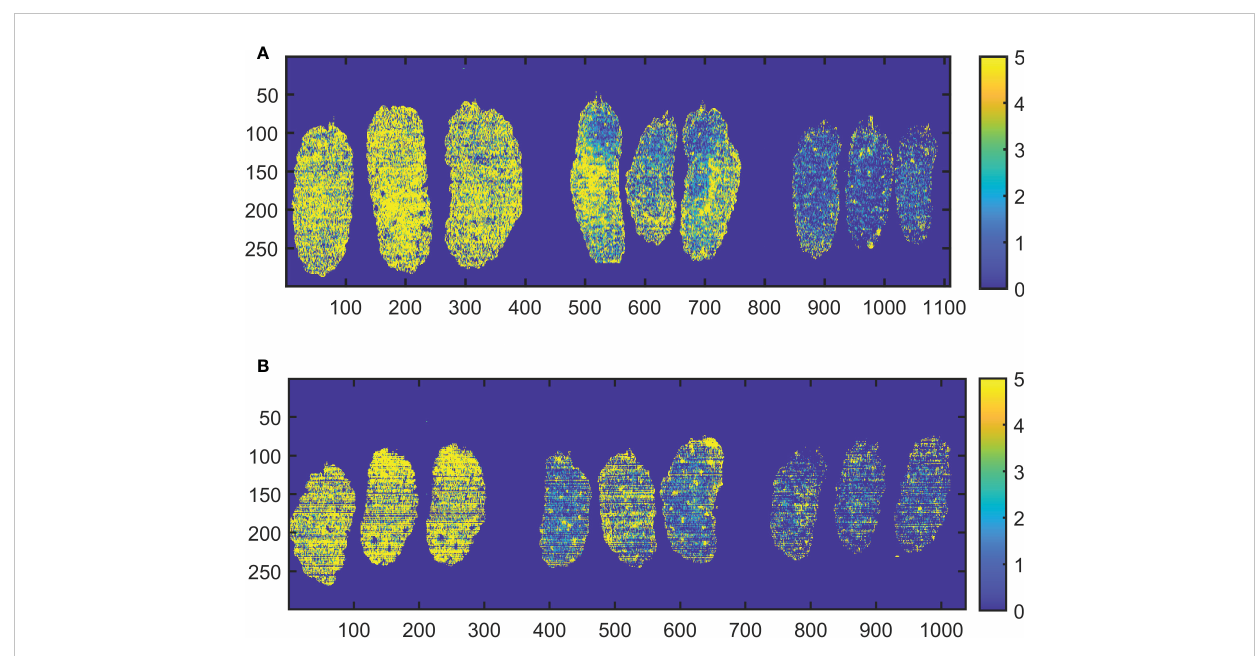
FIGURE 9 Visualization of anthocyanin content in mulberry fruits of Dashi (A) and Siji (B) at three maturity